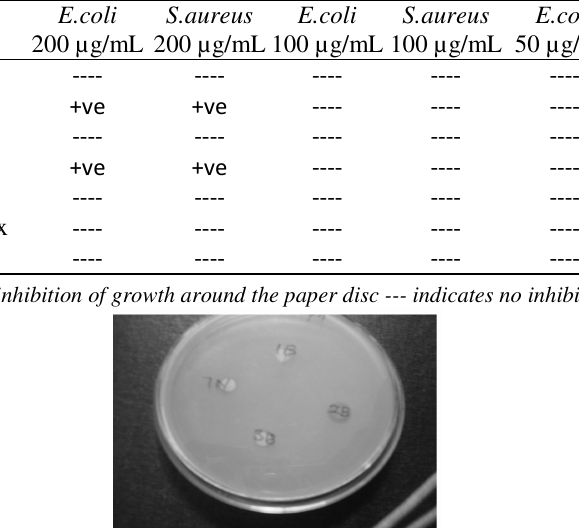
Table 4. Antimicrobial acivity of complexes (inhibition of growth)